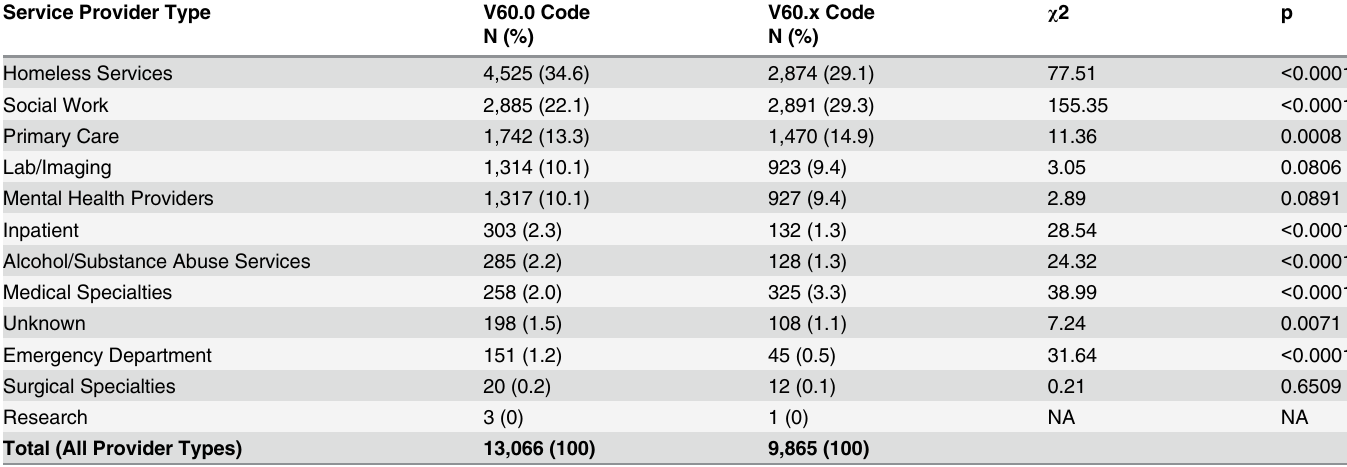
Table 4. Type of service providers assigning V60 codes to administratively code for homelessness for the first time among a cohort of OEF/OIF/ OND Veterans, 2001 – 2012. Note. Values represent N (%). χ 2 test and p-value come from z-tests for independent proportions with a correction for